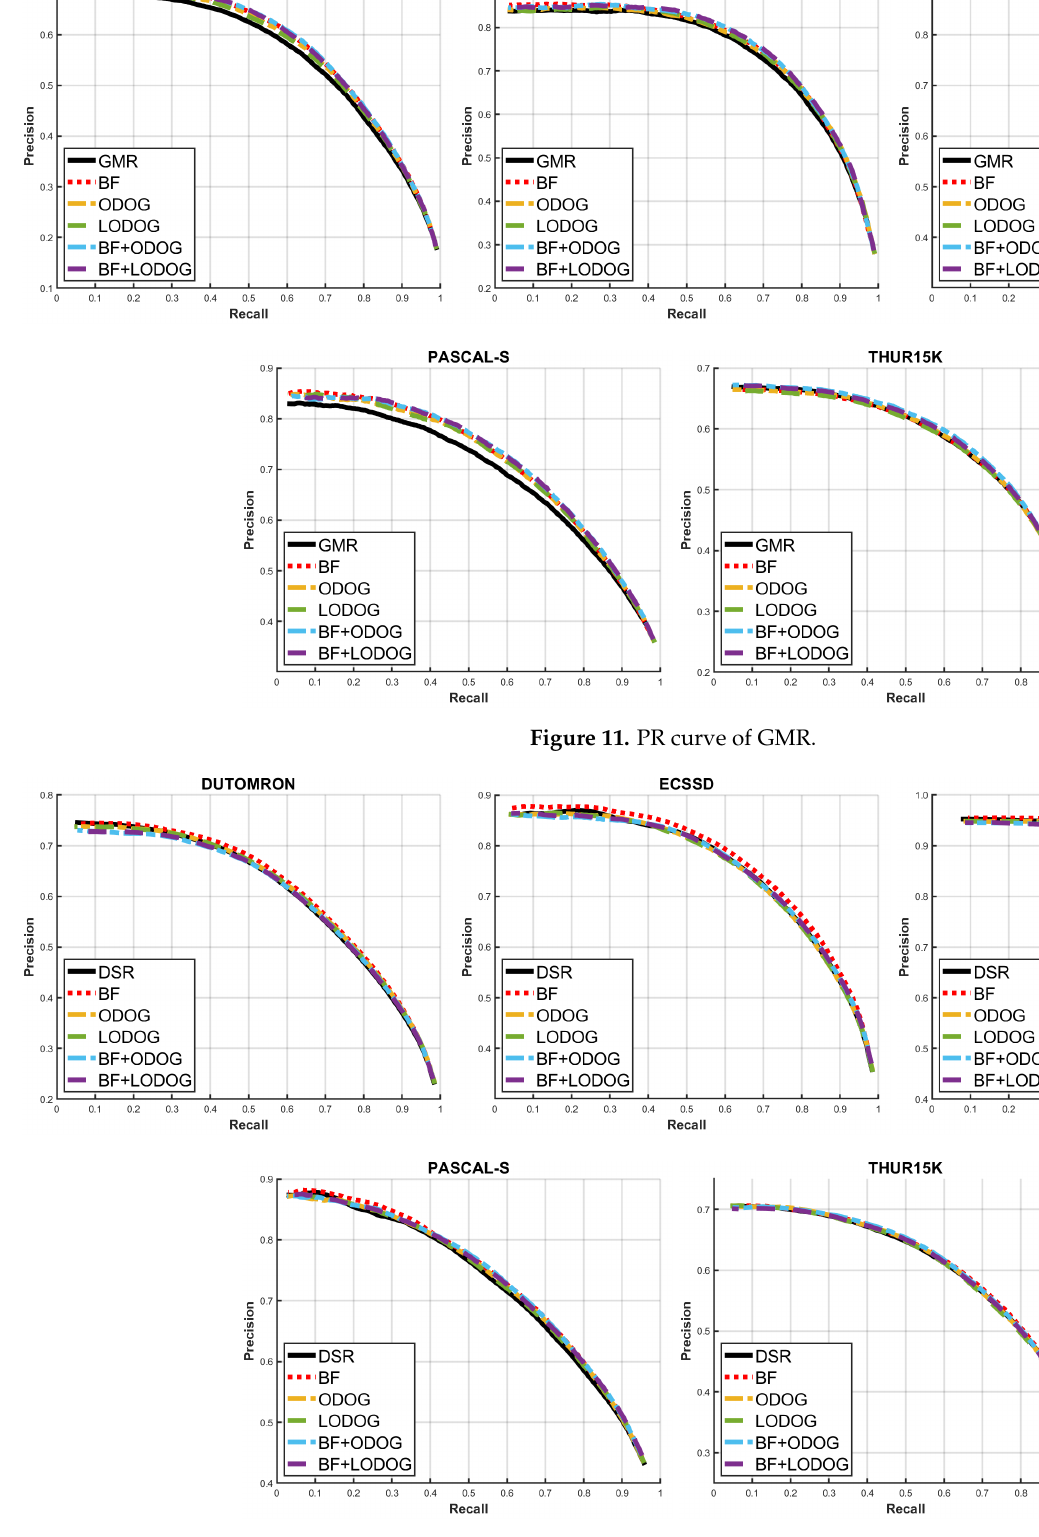
Figure 12. PR curve of